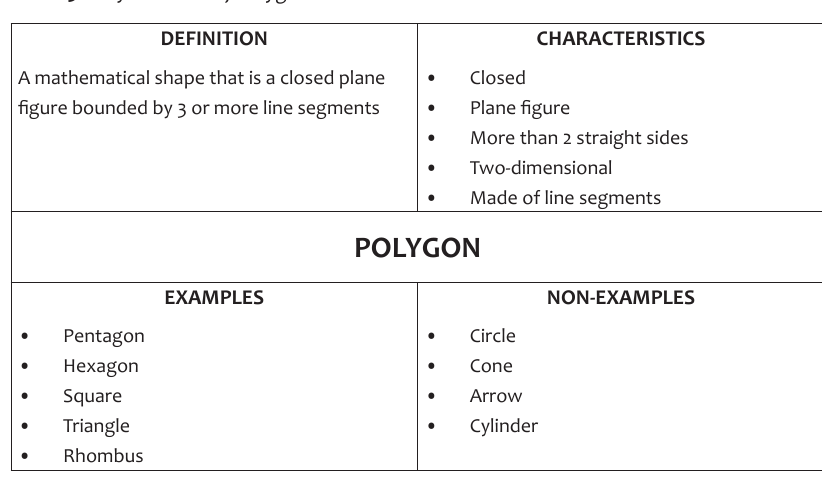
Table 5: Frayer Model of Polygon